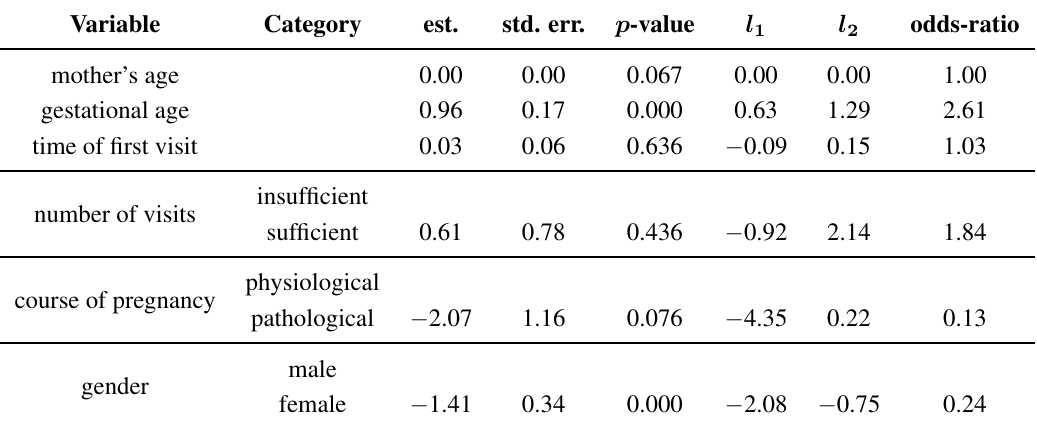
* Estimated odds-ratios refer to normal or high birthweight infants vs. low birthweight infants and to high birthweight infants vs. low or normal birthweight